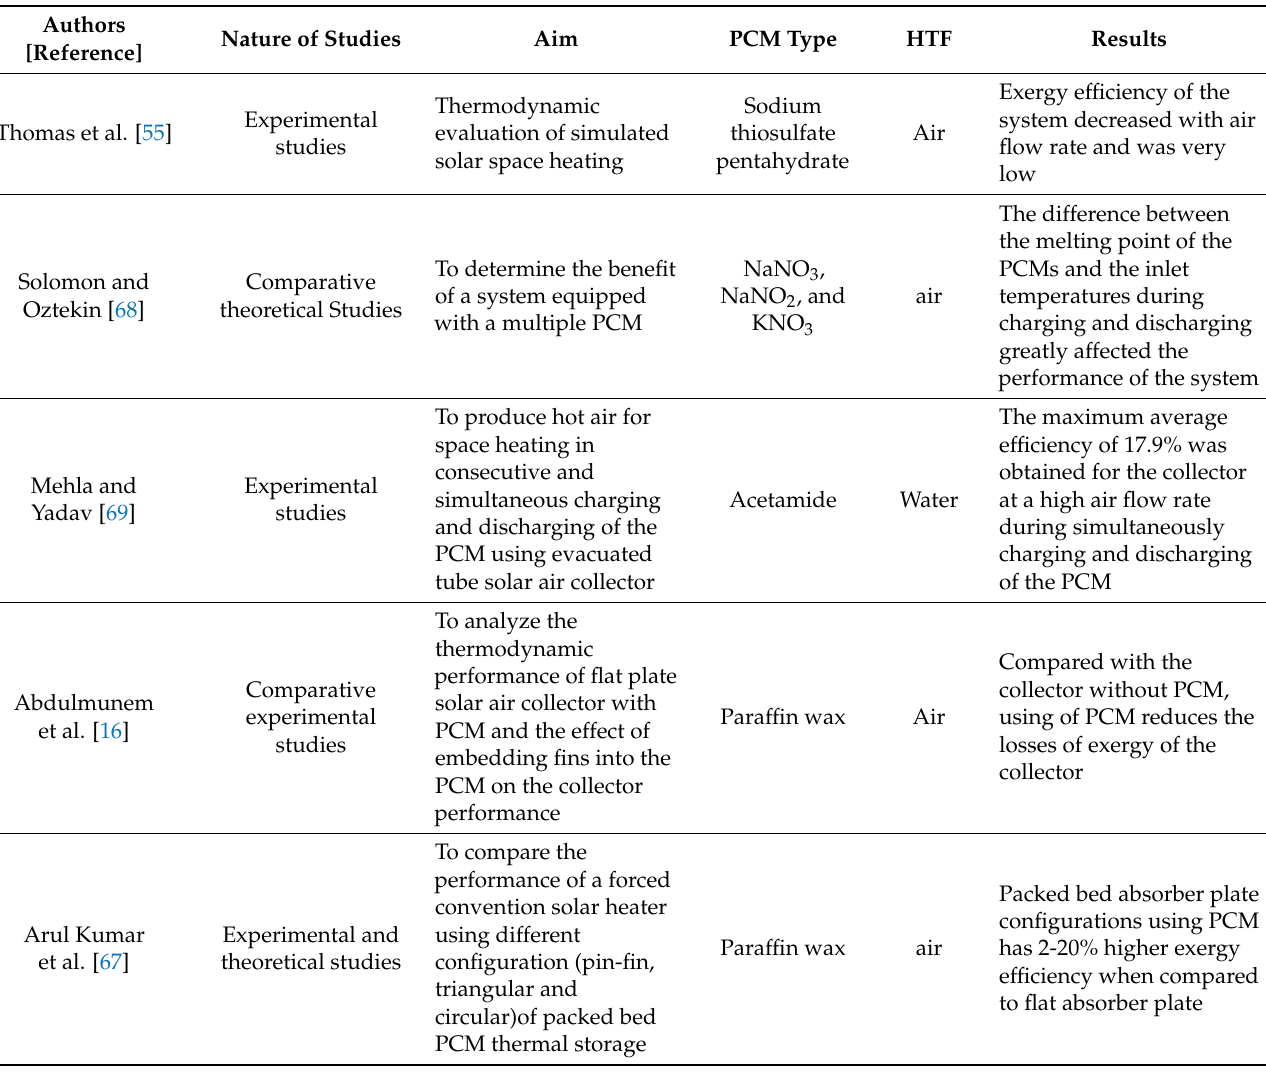
Table 6. Results of some of the studies presented on space heating and the PCM